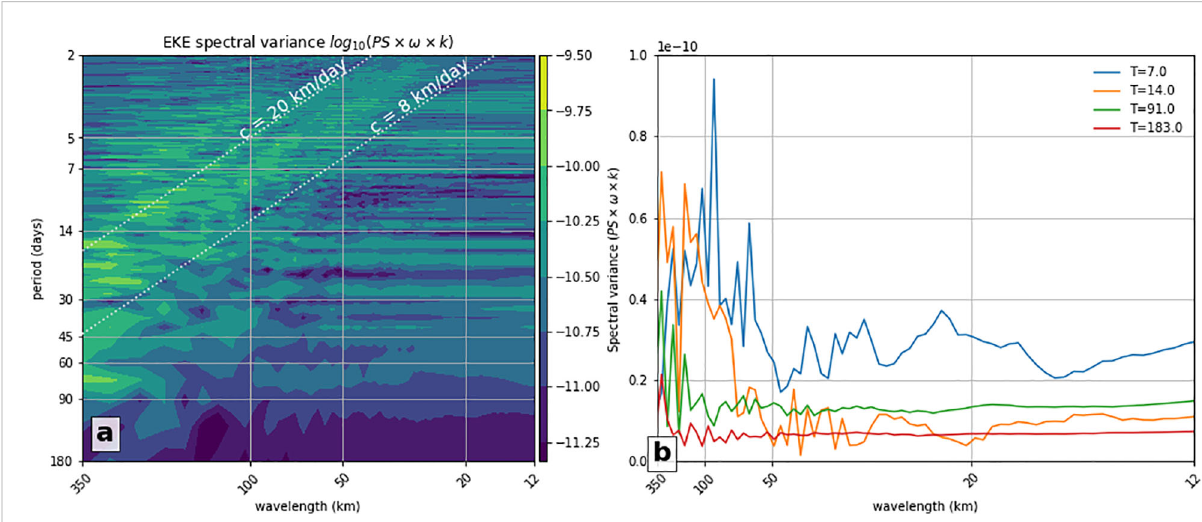
FIGURE 3 The variability of the EKE anomaly at 500 m along the XBT-S transect is explored for the ref state over the period Jan 2012 – Jan 2013, with the (A) log 10 wavelength – period power spectrum of the EKE at 500 m and (B) power spectrum of the EKE at 500 m at four selected periodicities. In both panels, the power spectrum is the variance-preserving spectral density, calculated as the power scaled by the frequency and wavenumber, which more evenly weights signalsat higher frequencies and smaller length-scales. The chosen periodicities in (B) are 7 days, 14 days, ~90 days and ~180 days. The EKE anomaly is calculated by subtracting the EKE from the time-mean EKE at each longitude. The grey dashed lines in (A) show the non-dispersive relationship, w = ck , between frequency w and wavenumber k . The slope of the line, c , corresponds to the eddy phase speed, which is shown for two values: 8 km/day and 20 km/day.